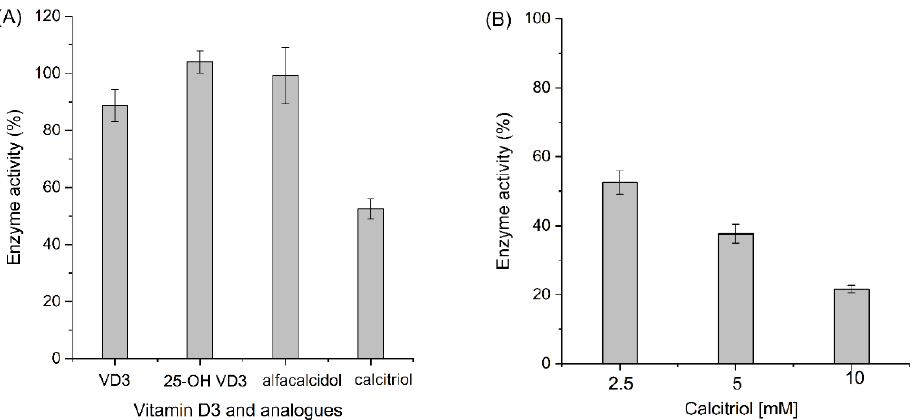
Figure 5. Enzyme activity after incubating with vitamin D3 and its analogs ( A ), and calcitriol with increased concentration ( B ). Reaction conditions of A : [ Aae UPO] = 0.5 μM, [substrate] = 2.5 mM, [H 2 O 2 ] = 1.0 mM h −1 , NaPi buffer (50 mM, pH 6), 40% ( v / v ) acetone, 5 h, 25 °C. Reaction conditions of ( B ): [substrate] = 2.5 – 10 mM with the other condition unchanged. Error bars indicate the standard deviation of triplicate experiments ( n = 3).